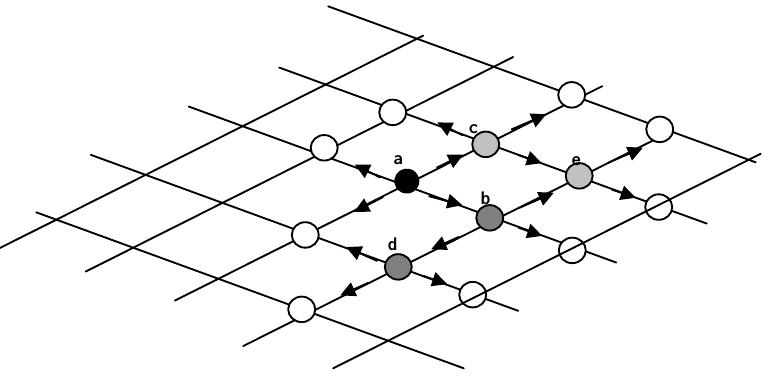
Figure 4. Example of processing stages by the proposed fast level set